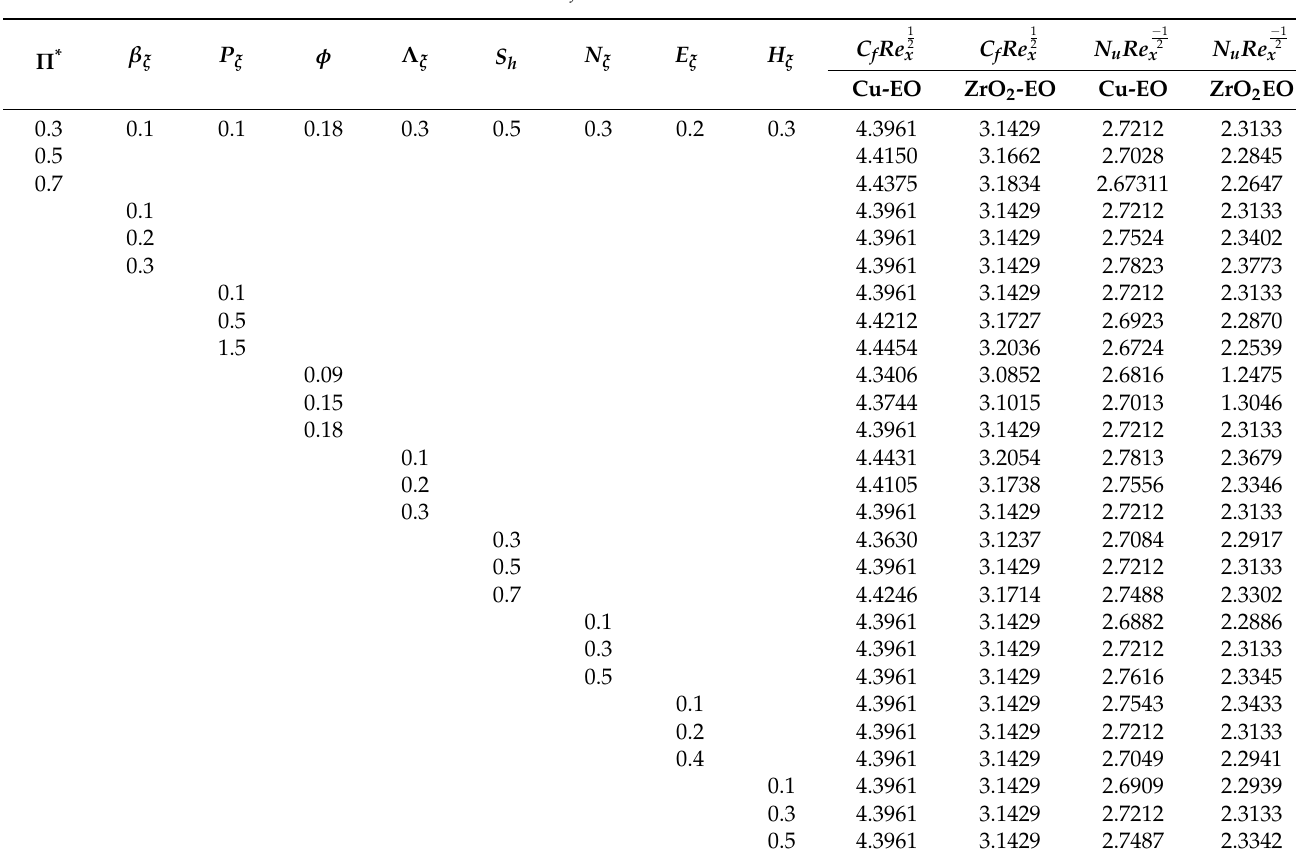
Figure 21. Entropy profile change with φ . Table 5. Values of C f Re 1/2 x and Nu x Re − 1/2 x for P r =